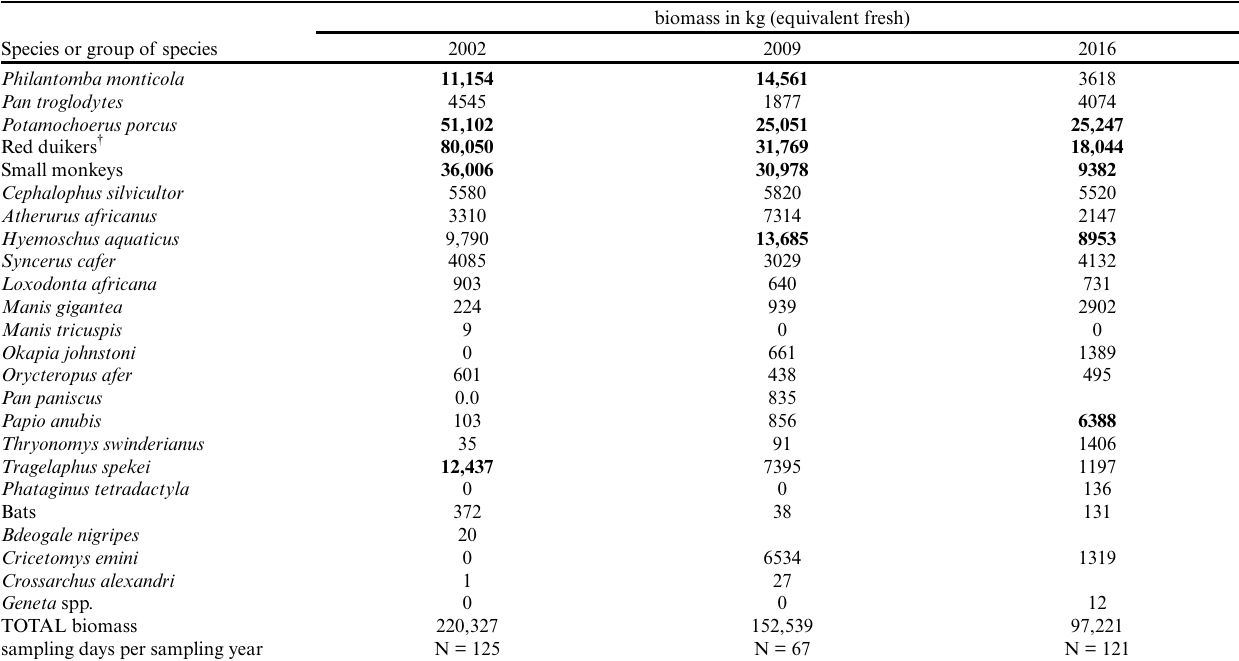
† Several red duiker species ( Cephalophus callipygus , Cephalophus dorsalis , etc.) are lumped into one group because carcasses were not always identified to species level at the market.